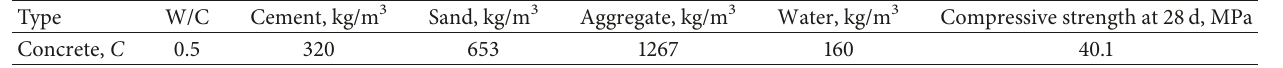
Table 1: Composition of the concrete used in this project.